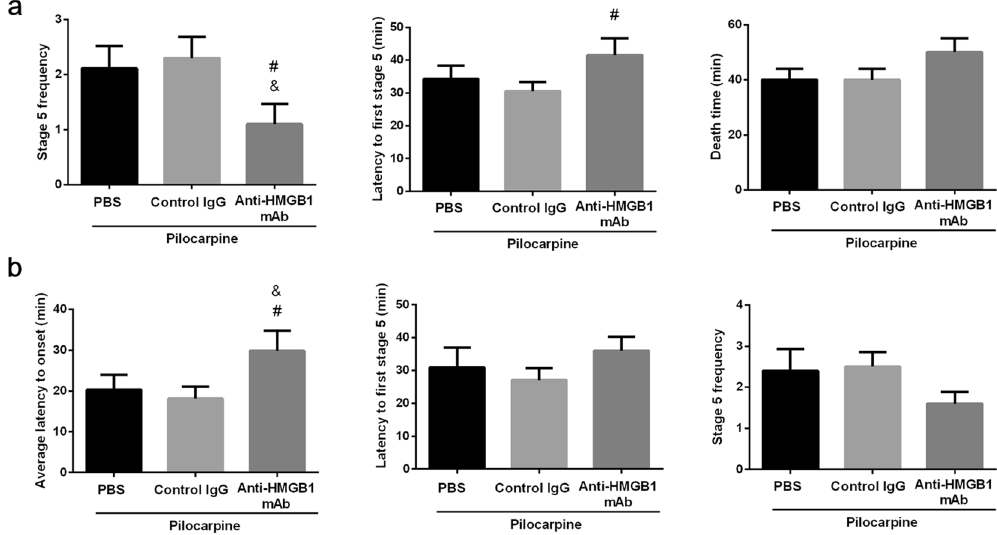
Figure 8. The pre-treatment and post-treatment of anti-HMGB1 mAb on acute seizure behavior. Pre- treatment: Anti-HMGB1 mAb, control IgG or PBS was administered intravenously 4 h before pilocarpine (350 mg/kg, i.v.) injection. All data were collected in 60 min after pilocarpine treatment. The frequency of seizure stage 5, latency to stage 5 and the time to death were determined on each mouse. The results are shown as the means ± SEM of 9 mice. & p < 0.05, compared with the PBS control. # p < 0.05, compared with the control IgG group ( a ). Post-treatment: anti-HMGB1 mAb, control IgG or PBS were immediately injected after pilocarpine injection, and behavior test were observed under 60 min observation. The latency to onset and stage mice. & p < 0.05, compared with the PBS control. # p < 0.05, compared with the control IgG group ( b